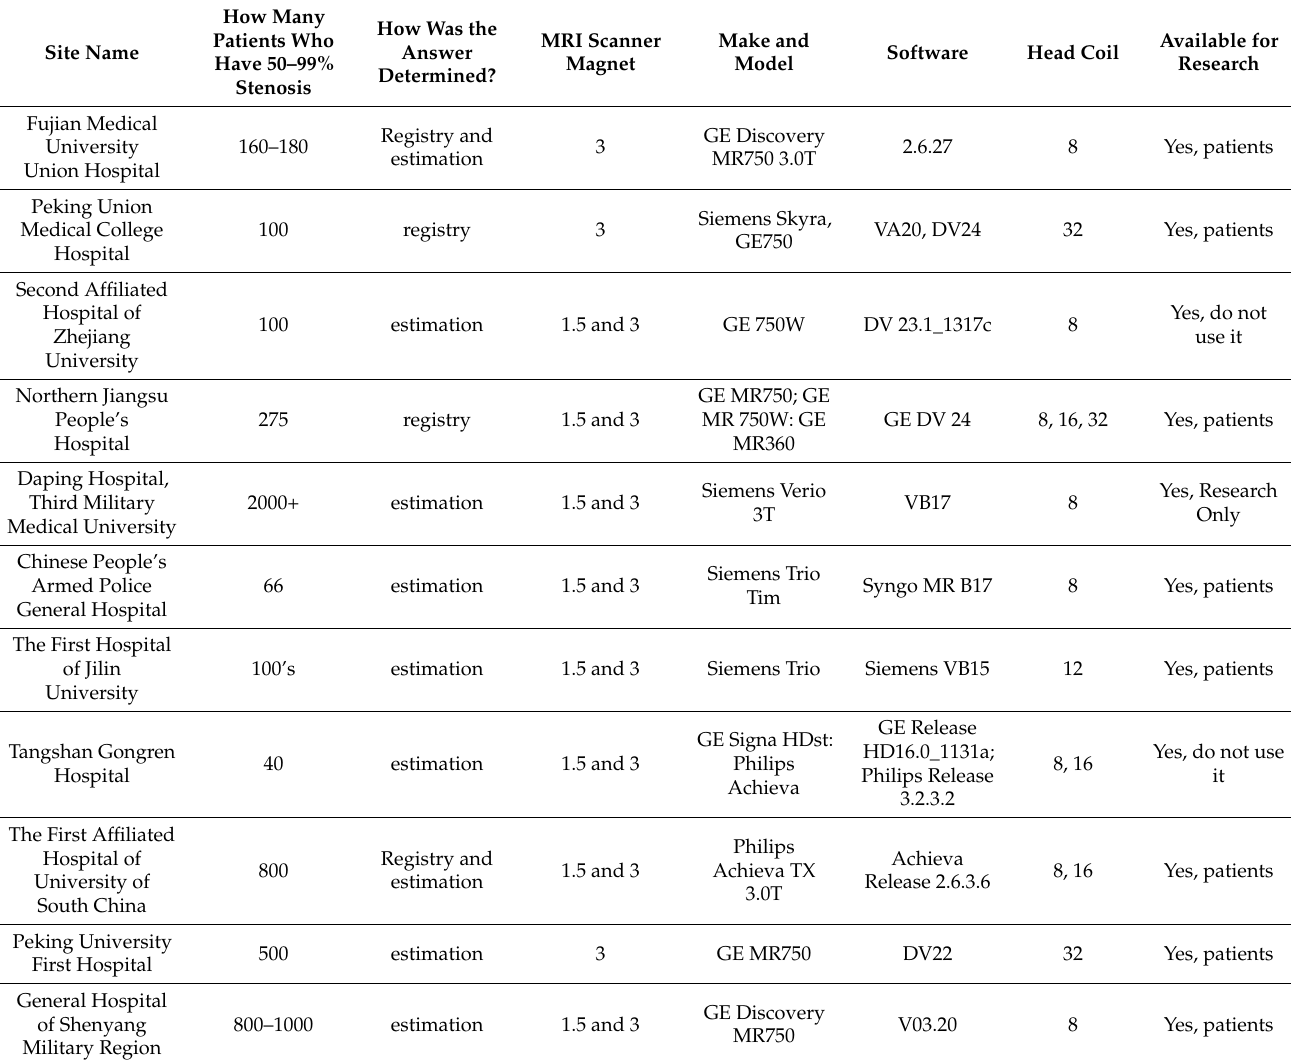
Table 1. Selected VW-MR sites in China.